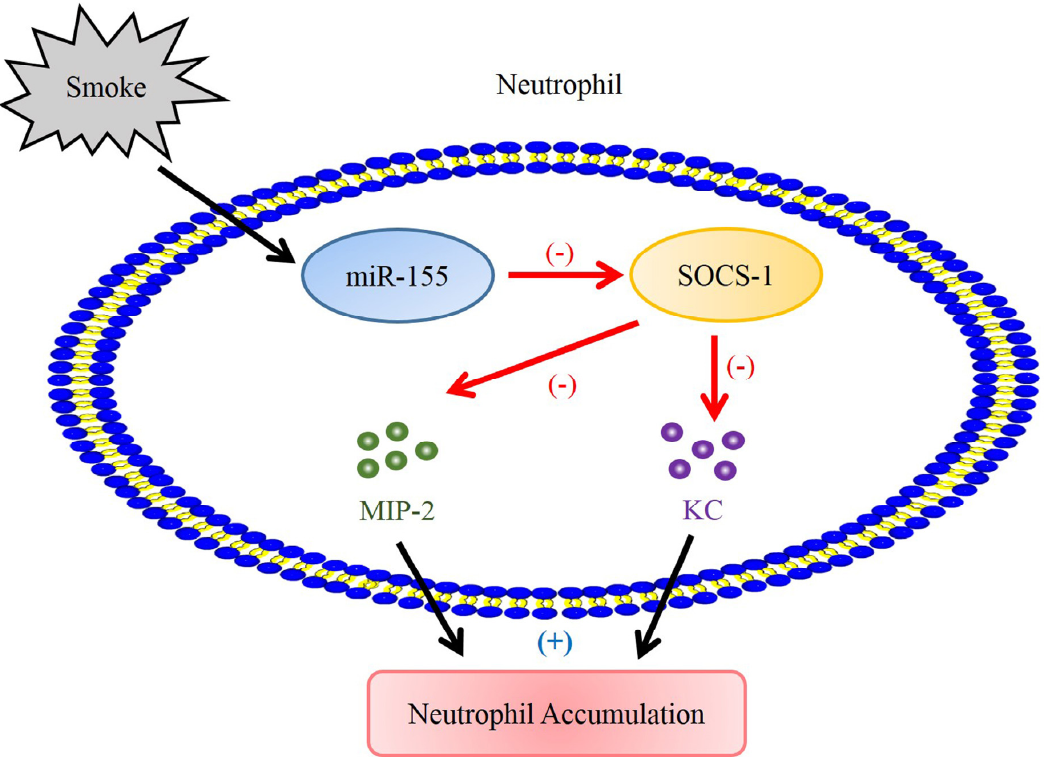
Figure 6. Model of miR-155-modulated neutrophil activation and recruitment through suppression of SOCS-1 smoke-induced in pulmonary neutrophil. Smoke-elevated miR-155 expression suppresses SOCS-1, which is a negative regulator of neutrophil chemoattractants. Subsequently, upregulated MIP-2 and KC function cooperatively to promote neutrophil accumulation in the lung.